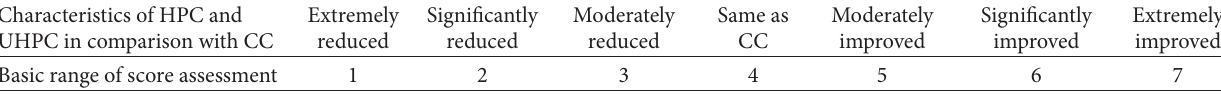
Table 1: View of valuation subject on characteristic of HPC and UHPC in comparison with CC. Extremely Significantly Moderately Same as Moderately Significantly Extremely reduced reduced reduced CC improved improved improved